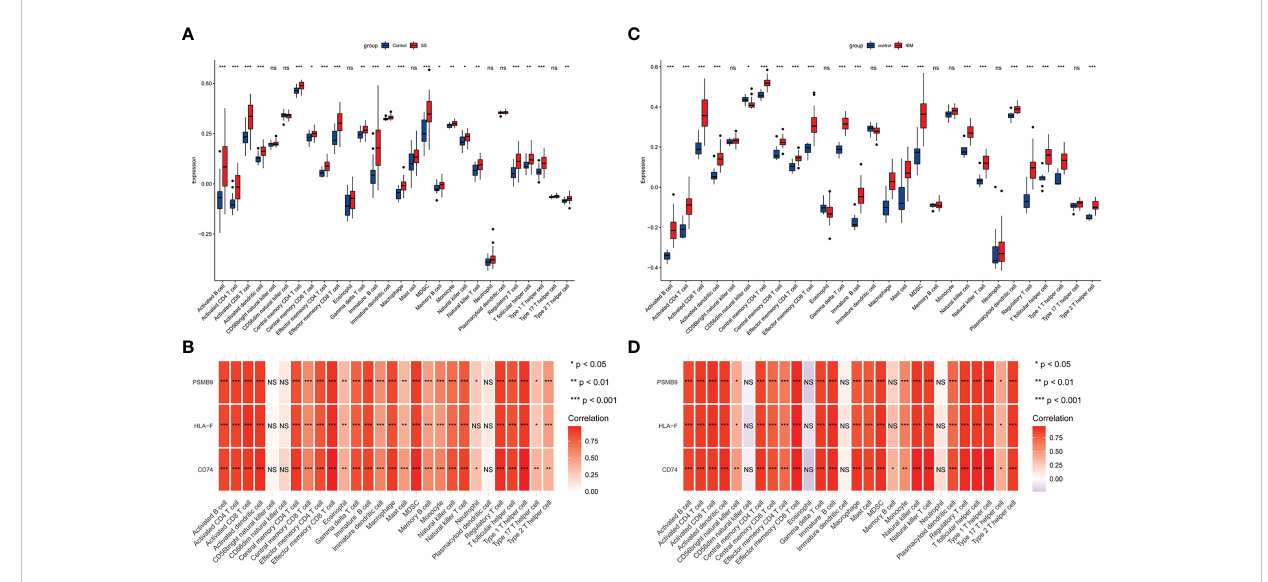
FIGURE 7 The immune in fi ltration landscape in SS and IBM and its association with hub genes. (A) Analysis of 28 types of immune cells in SS patients and controls with the ssGSEA algorithm. The blue box represents the control group, while the red box indicates the disease group. (B) Hub genes and immune cell in fi ltration heatmaps in SS. (C) Analysis of 28 types of immune cells in IBM patients and controls with the ssGSEA algorithm. (D) Hub genes and immune cell in fi ltration heatmaps in IBM. * p < 0.05; ** p < 0.01; *** p < 0.001; ns, non-signi fi cant. SS, Sjögren syndrome; IBM, inclusion body myositis.